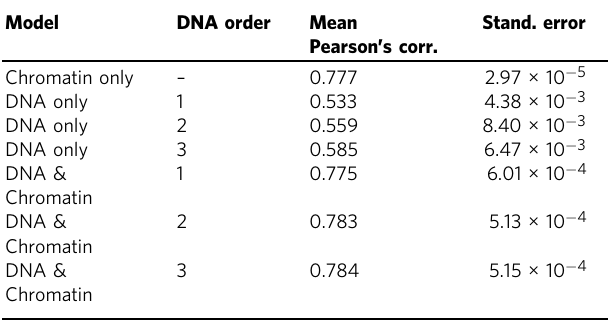
Correlation was measured between observed and predicted normalized CAGE-counts. The models use DNA or Chromatin (DNase and H3K4me3) either separately or simultaneously as input. Different one-hot encoding orders were compared to represent DNA